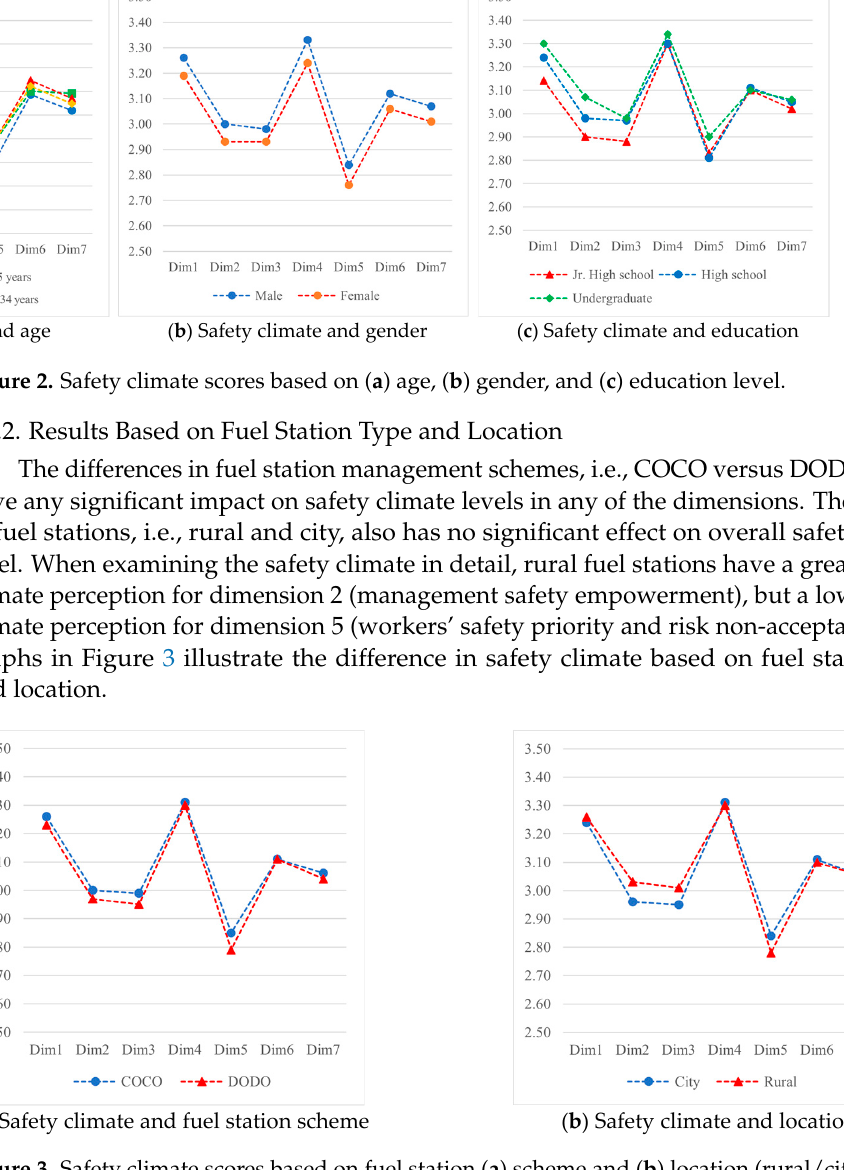
Figure 3. Safety climate scores based on fuel station ( a ) scheme and ( b ) location (rural/city).